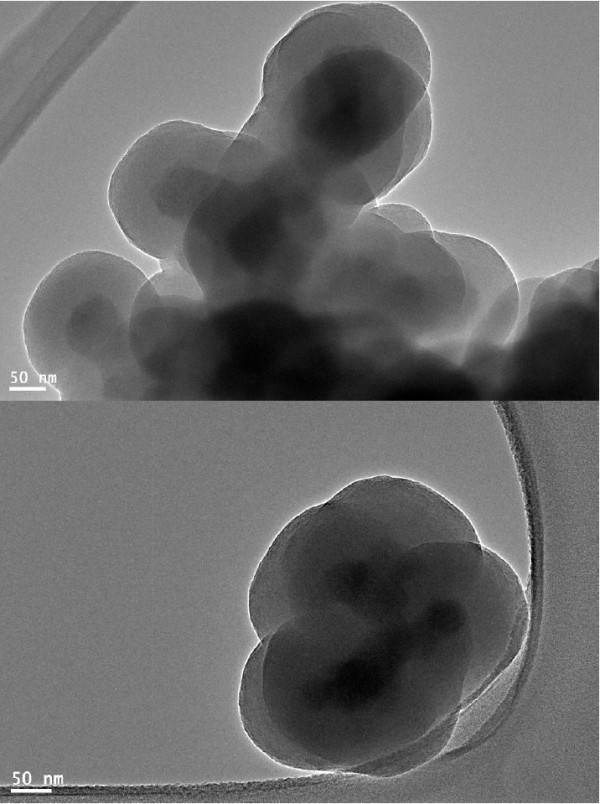
Typical FE-TEM micrographs of luminescent mesoporous Tb(OH)3@SiO2core-shell nanosphere.